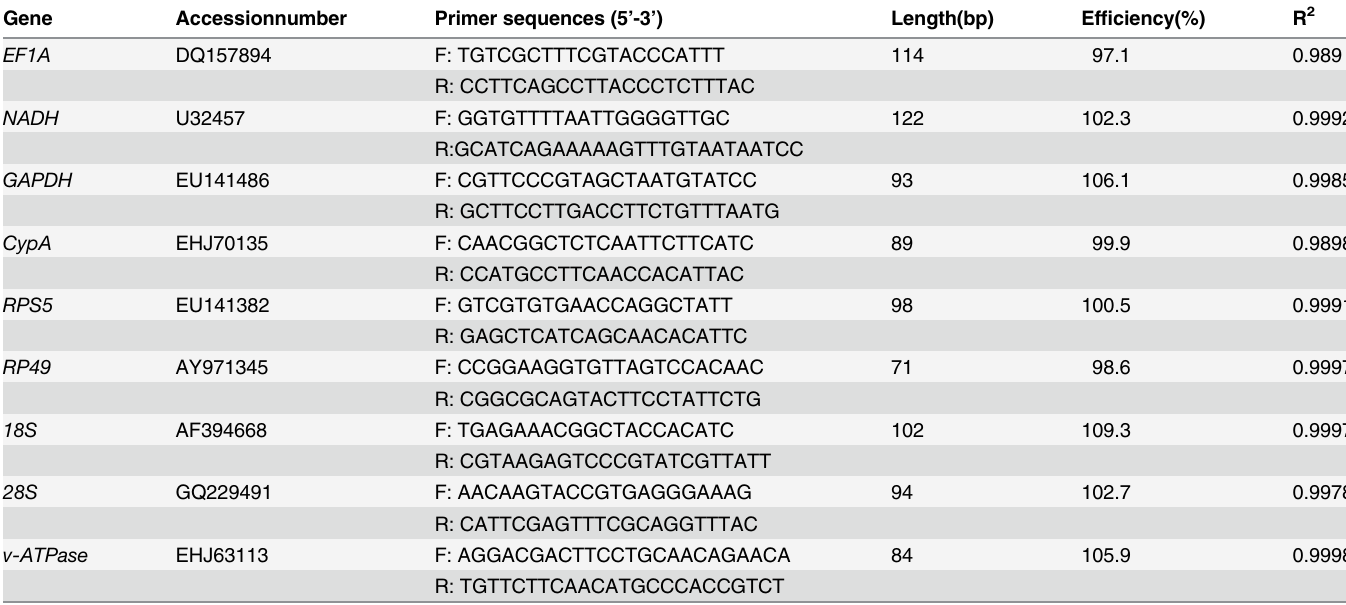
Table 1. Primers used for